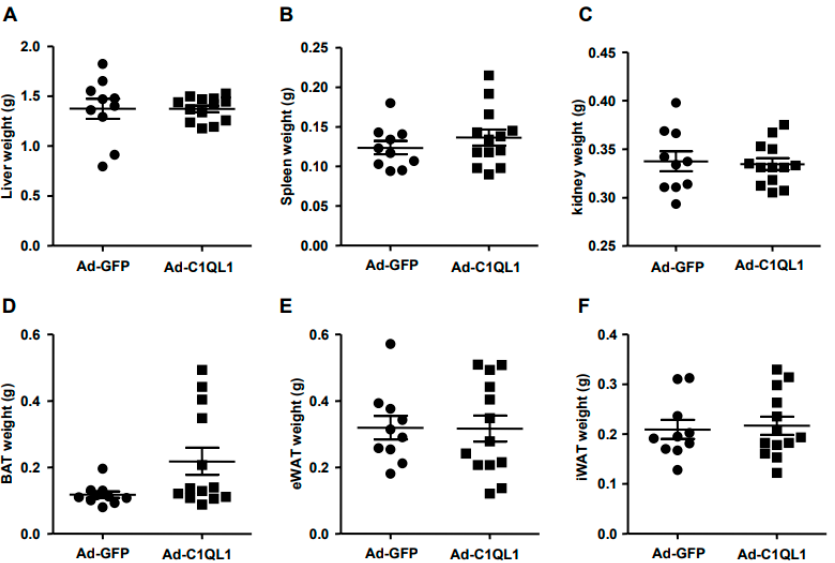
Figure 3. The tissues and organs weight. ( A ) Liver weight; ( B ) Spleen weight; ( C ) Kidney weight; ( D ) BAT weight; ( E ) eWAT weight; ( F ) iWAT weight. Data are presented as the mean ± SEM. n = 10 or 13 for each cohort. ApoE KO mice were euthanized, and their tissues and organs were isolated and weighed. BAT, brown adipose tissue; eWAT, epididymis white adipose tissue; iWAT, inguinal white adipose tissue.